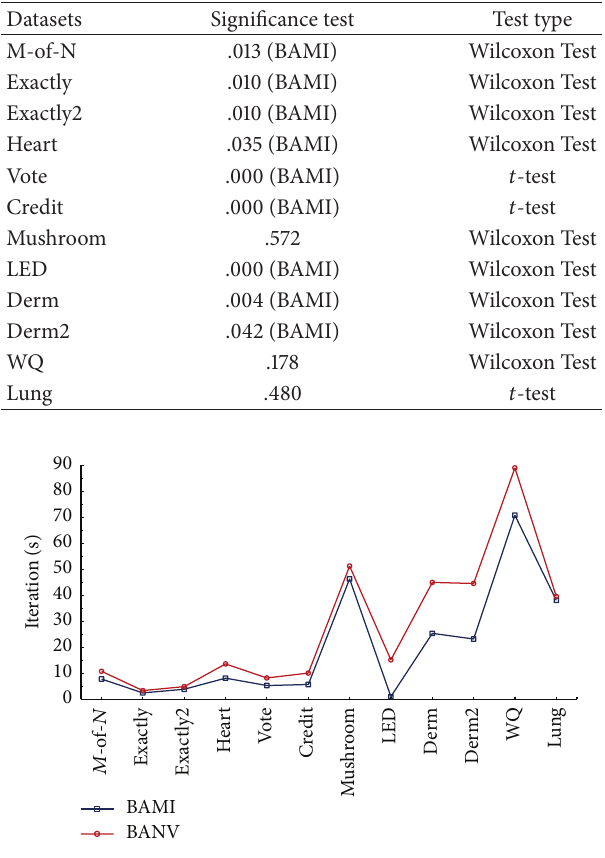
Figure 2: Average numbers of iterations across all